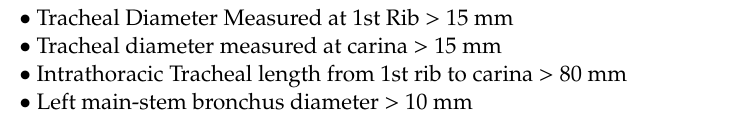
Table 3. Predictors of a larger than standard tracheostomy tube using chest plain film